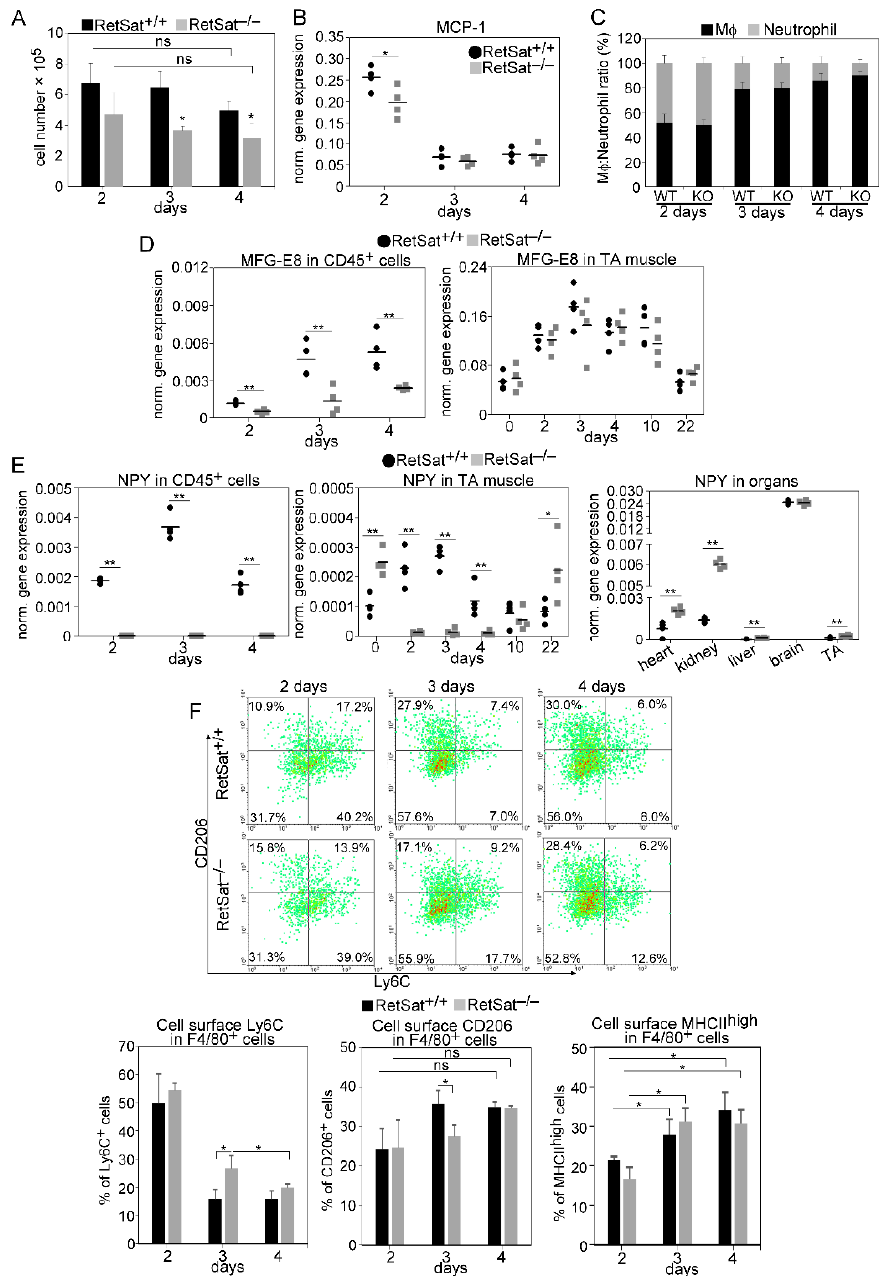
Figure 5. Decreased tissue infiltration and altered polarization of muscle-derived F4/80 + cells in the absence of RetSat. ( A ) The number of CD45 + leukocytes per injured muscle and ( B ) MCP-1 mRNA expression levels of muscle-derived CD45 + leukocytes from wild-type or RetSat-null mice, determined by qRT-PCR following CTX-induced injury ( n = 4). ( C ) Ratio of anti-F4/80 antibody-stained M φ s and anti-Ly6G/Ly6C (GR-1)-stained neutrophils within the CD45 + leukocyte populations in the TA muscles from RetSat +/+ and RetSat − / − mice during the first 4 days of regeneration following CTX-induced injury ( n = 3). ( D ) Expression of MFG-E8 mRNA and ( E ) of NPY mRNA in muscle-derived CD45 + leukocytes, in total TA muscles, and various organs of RetSat +/+ and RetSat − / − mice, determined by qRT-PCR following CTX-induced injury ( n = 4). ( F ) Representative scatter plots of CD206- and Ly6C-stained muscle-derived F4/80 + cells and the percentages of Ly6C + , CD206 + , and MHCII high cells within the muscle-derived F4/80 + population determined at the indicated days following CTX-induced injury in the TA muscles of RetSat +/+ and RetSat − / − mice ( n = 3). Asterisks indicate statistical significance (* p < 0.05, ** p < 0.01); ns, not